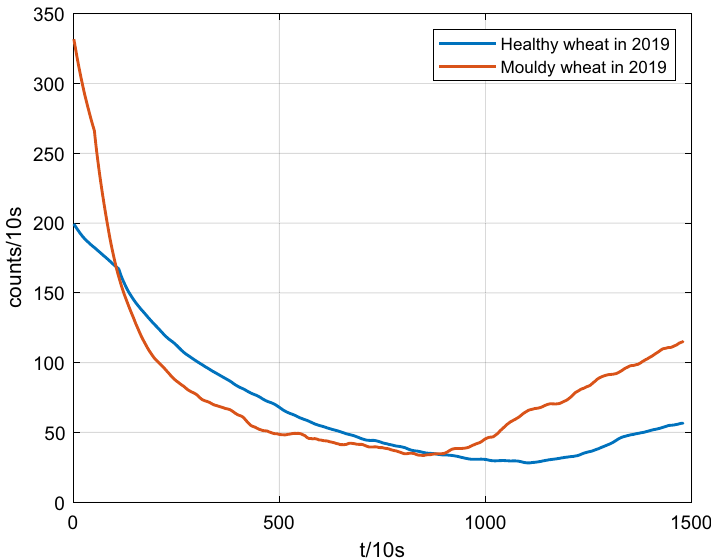
Figure 3. Average UWL data of the healthy and the moldy wheat subsamples.